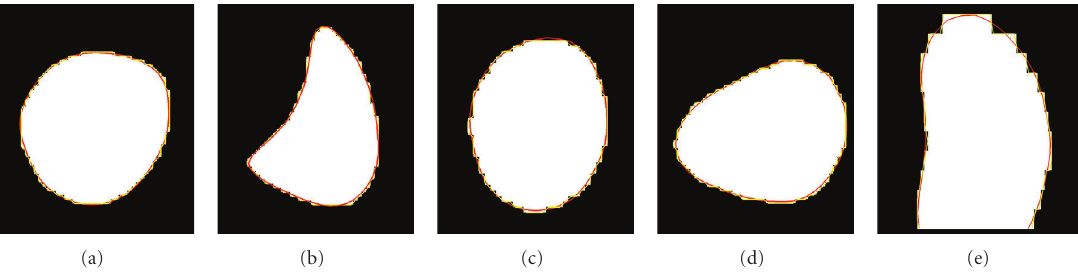
Figure 10: Contours of endocardial meshes generated by the marching cubes (yellow) and the proposed method (red) in short-axis sections for (a) left ventricle, (b) right ventricle, (c) left atrium, and (d) right atrium, and in a long-axis section for (e) left ventricle. The endocardial boundaries are defined by the blood pool segmentation shown in the binary